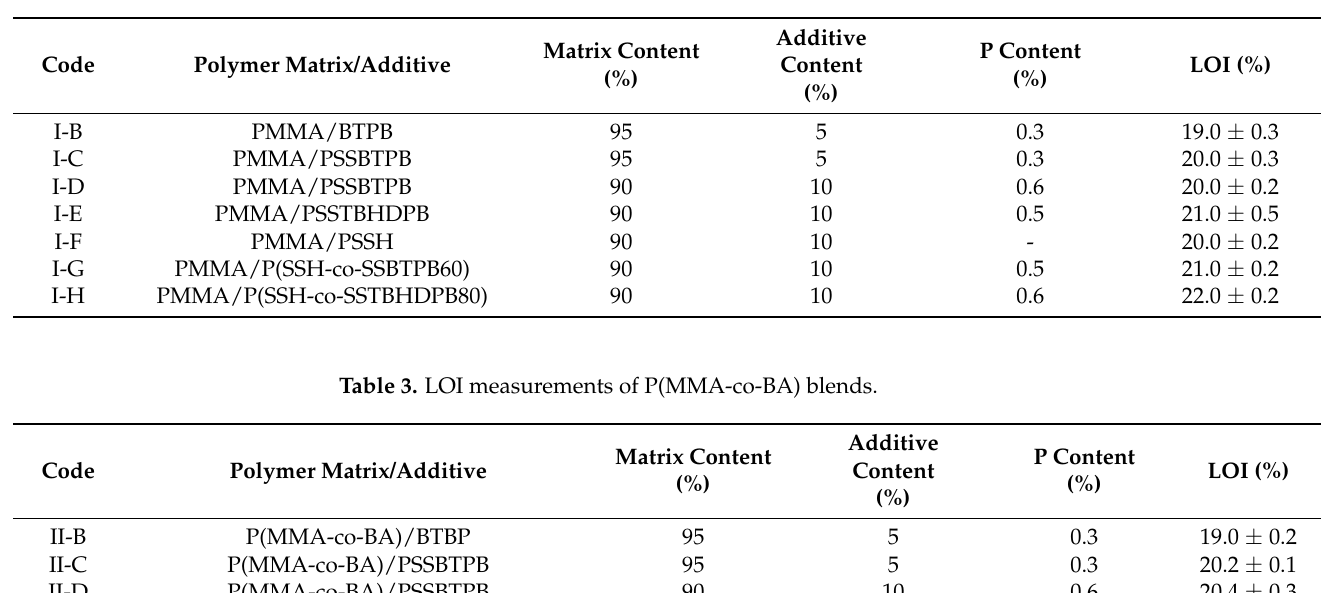
Table 2. LOI measurements of PMMA blends.